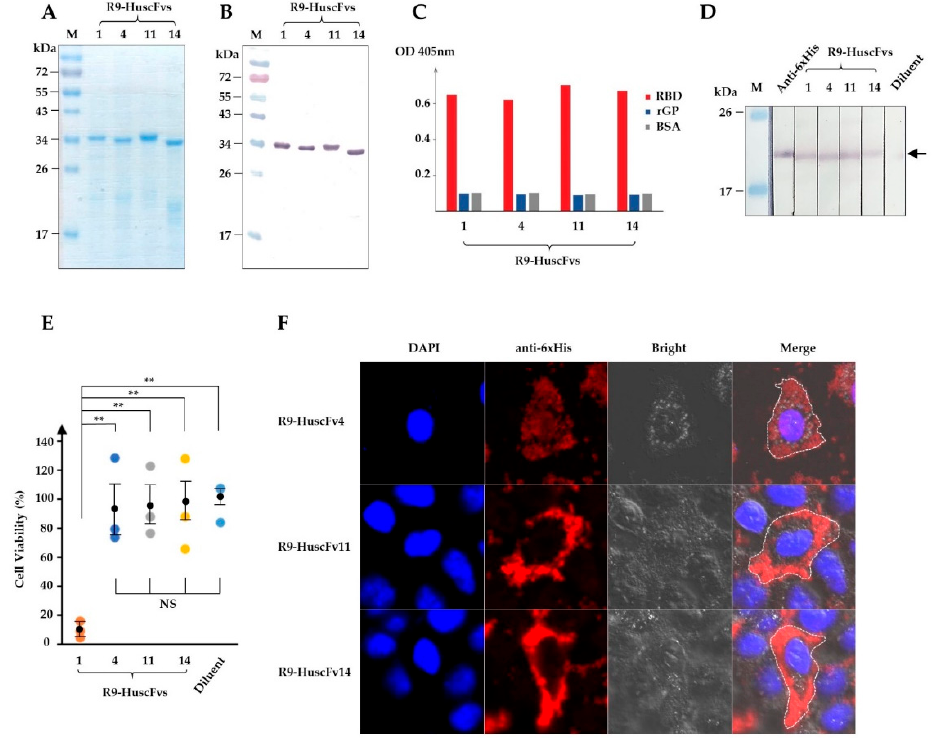
Figure 2. Production of R9-HuscFvs and their rRBD binding activity, biocompatibility to human cells, and cell-penetrating ability. ( A ) R9-HuscFvs were produced, purified, and verified by SDS-PAGE and CBB staining. ( B ) Western blotting of R9-HuscFvs that corresponds to ( A ), detected by anti-6 × His antibody. ( C ) Binding of R9-HuscFvs to rRBD and recombinant full-length GP (rGP) by indirect ELISA. ( D ) R9-HuscFvs binding activity to rRBD blotted onto nitrocellulose strips. Arrowhead indicates the rRBD-R9-HuscFvs reactive bands. ( E ) Analysis of R9-HuscFv-mediated cellular cytotoxicity to HEK293T cells incubated overnight with 30 µg/mL of R9-HuscFvs or equivalent volume of antibody diluent. Results are shown as mean ± standard error of percent cell viability of three independent experiments in duplicates. **, p < 0.01; NS, not significantly different. ( F ) Cell-penetrating ability (intracellular localization) of R9-HuscFvs in HEK293T cells incubated with 30 µg/mL of R9-HuscFvs for 24 h, as observed by confocal microscopy. Each image shown is a representative of a 1-µm section from a series of z-stack analysis. Lanes M and numbers on the left of ( A , B , D ) are the protein molecular weight marker and protein molecular masses in kDa, respectively.